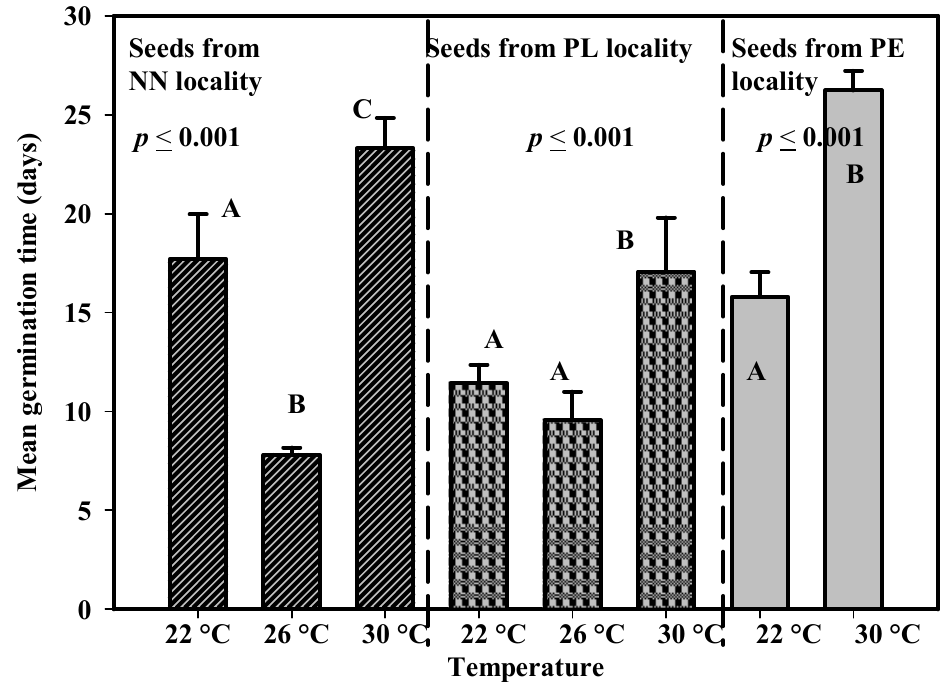
Figure 4. ANOVA results for comparison of the effect of temperature on the mean germination time (days) of seeds of D. cinnabari collected in the Sirhin (NN), Firmihin (PL), and Skant (PE) localities. Means with the same letter are not significantly different from each other ( p = 0.05).